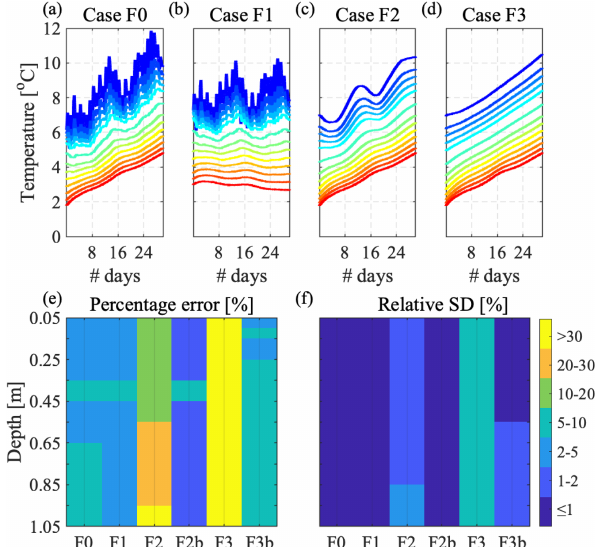
Figure 2. Impact of soil temperature trend and fluctuations on the MCMC inversion evaluated for various cases, including (a) sum- mer trend and fluctuations (F0), (b) detrended fluctuations (F1), (c) smoothed out daily and smaller fluctuations (F2), and (d) with- out fluctuations (F3). (e) Percentage error (Eq. 7) and (f) posterior relative standard deviation (Eq. 8) at each depth when using sliding time windows of 7d for all four temperature fields (F0–F3) and of 20d (F2b and F3b) for temperature fields F2 and